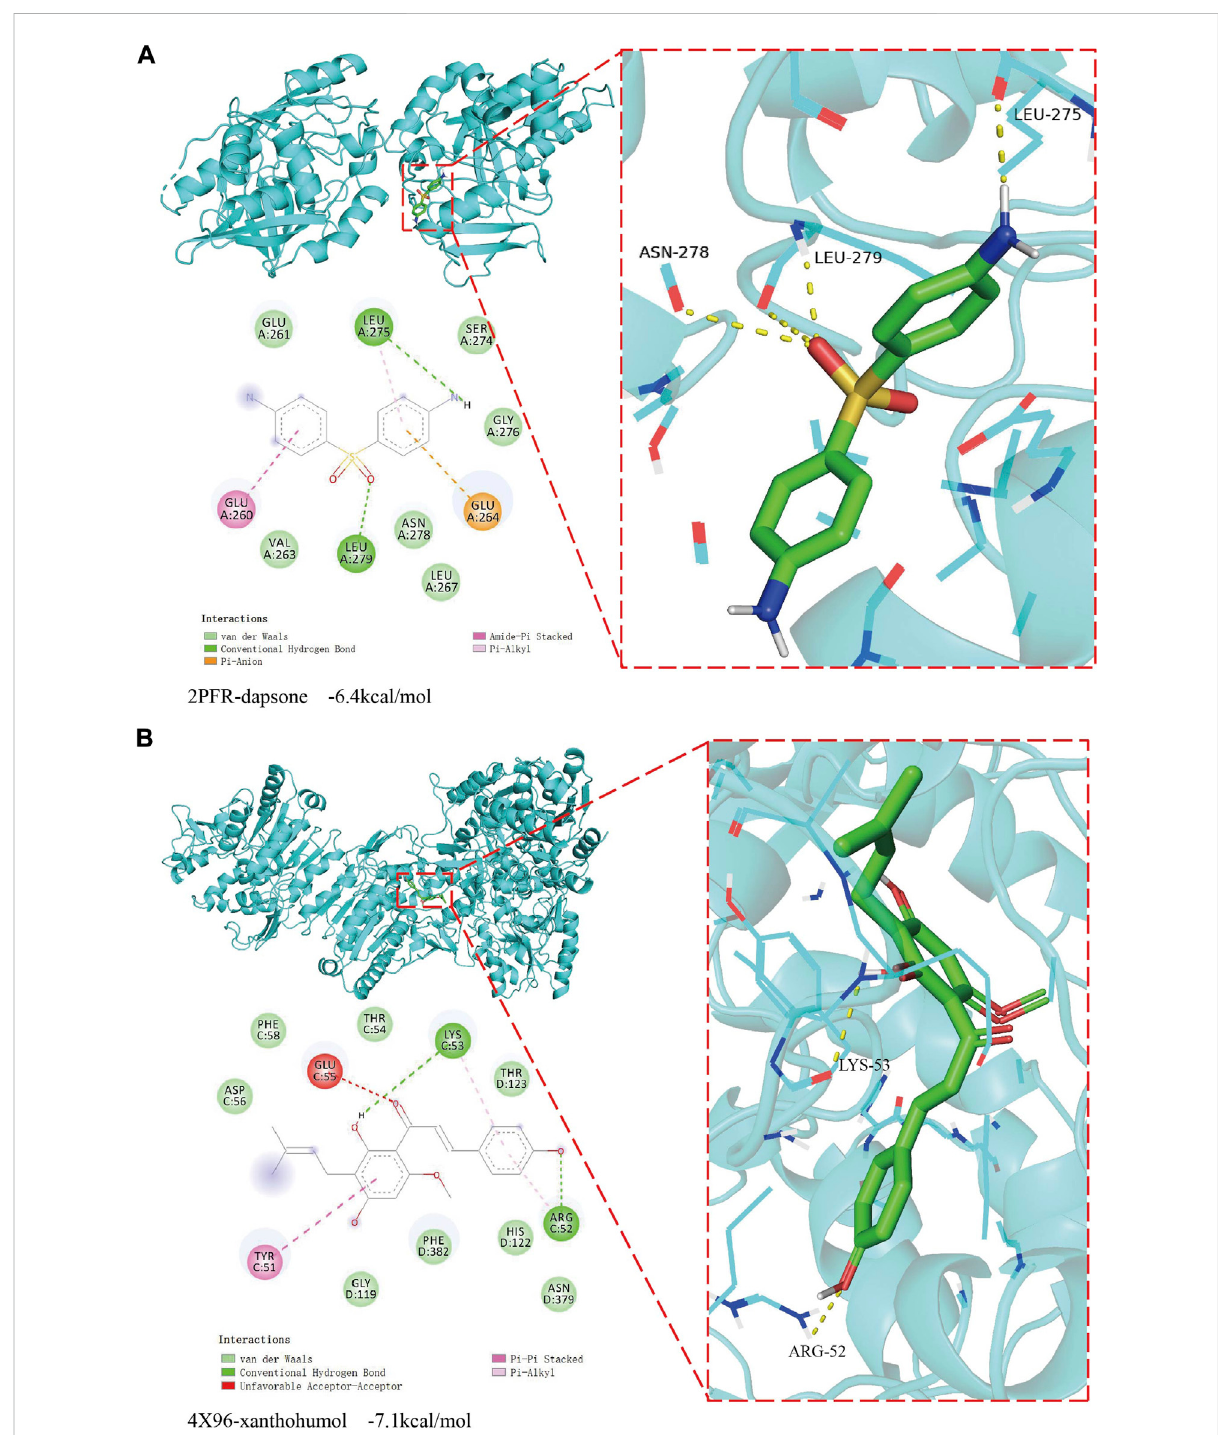
FIGURE 8 Theresultofmoleculardockingbetweencandidate drugsandtargets. (A) ThemoleculardockingresultsbetweendapsoneanditstargetNAT2. (B) The molecular docking results between xanthohumol and its target